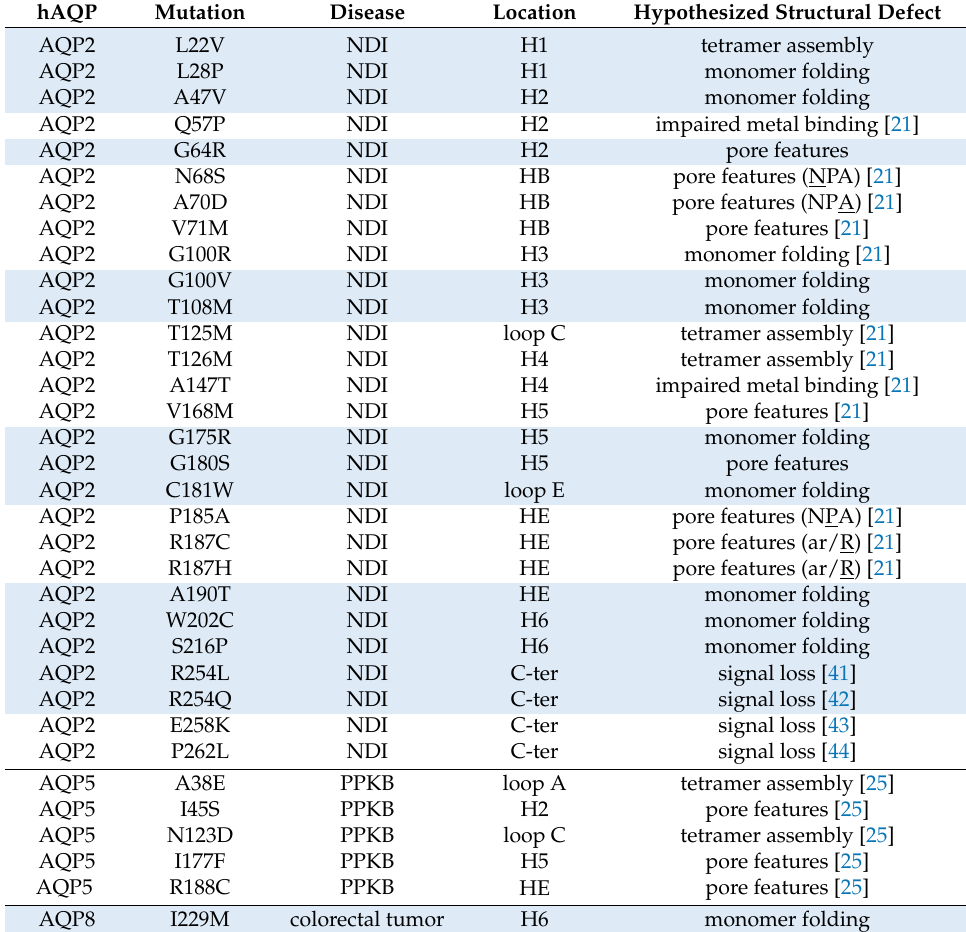
Table 2. Aquaporin SAPs associated to genetic diseases reported in Uniprot/Swiss-Protprotein knowledgebase (HUMSAVAR, updated to September 2017). Mutations whose structural basis is analysed here for the first time are highlighted. The hosting protein, specific SAP, associated disease (NDI: Nephrogenic Diabetes Insipidus, PPKB: PalmoPlantar Keratoderma of Bothnian type, colorectal tumor), structural location and hypothesized structural defect are reported for each mutant. When the mutation affects a residue of the NPA motifs or the ar/R site, it is indicated in parentheses with the mutated residue